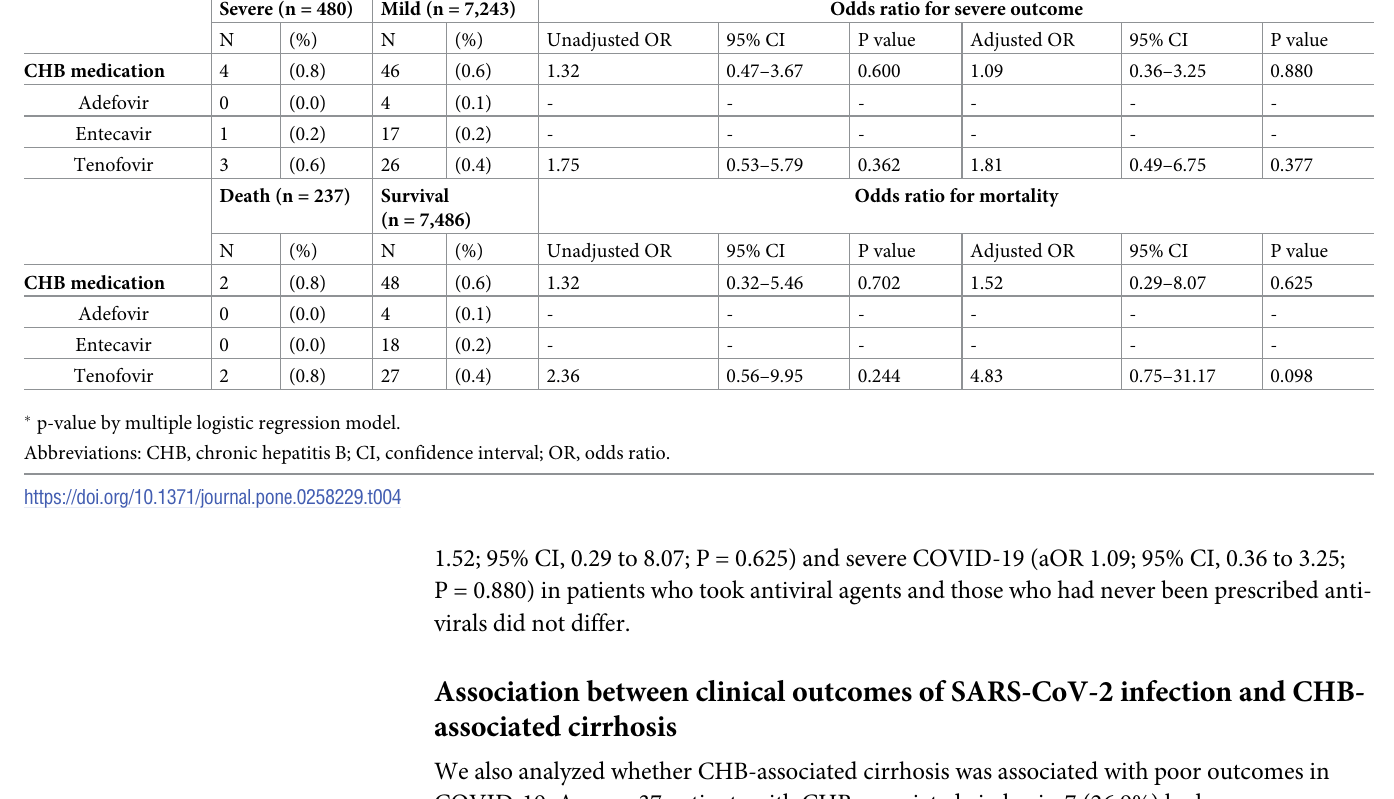
Table 4. Odds ratios for outcomes associated with use of CHB medication in COVID-19 patients. Severe (n = 480)